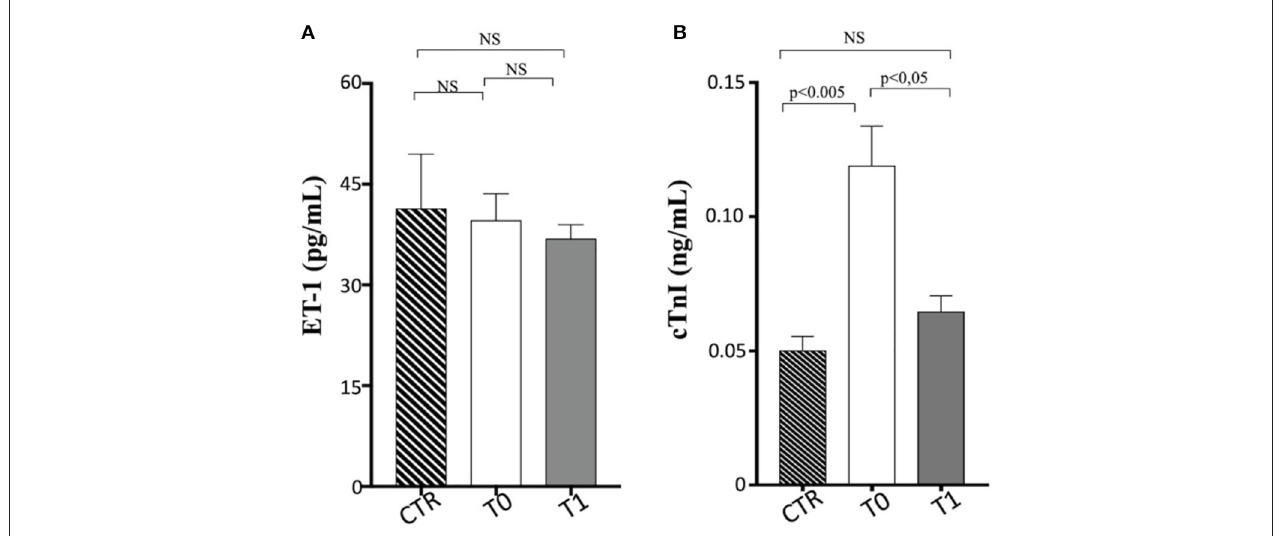
FIGURE 3 | Cardiovascular biomarkers in enrolled dogs. (A) ET-1, endothelin-1; (B) cTnI, cardiac troponin I. Control (CTR) group, dashed column; obese dogs at T0, white column; obese dogs at T1, gray column. Statistics: Wilcoxon matched-pairs signed-rank test was used for T0 and T1 comparation in obese dogs, while Mann–Whitney test was performed for the comparation between T0 obese dogs and CTR subjects. NS means not significant difference.